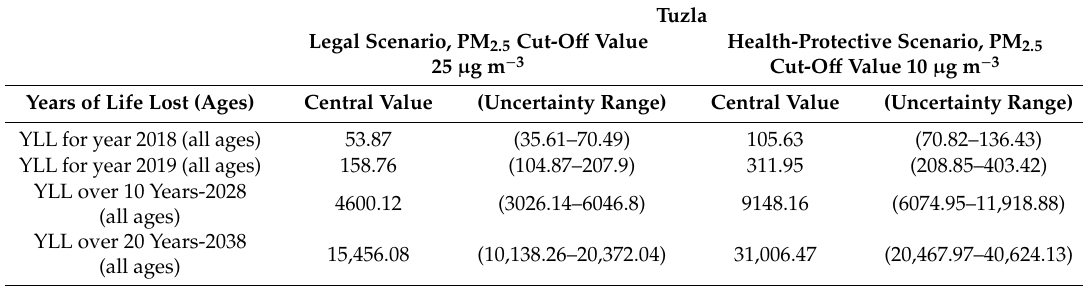
Table 4. Years of life lost (YLL) due to premature mortality for Tuzla, against two cut-o ff scenarios.